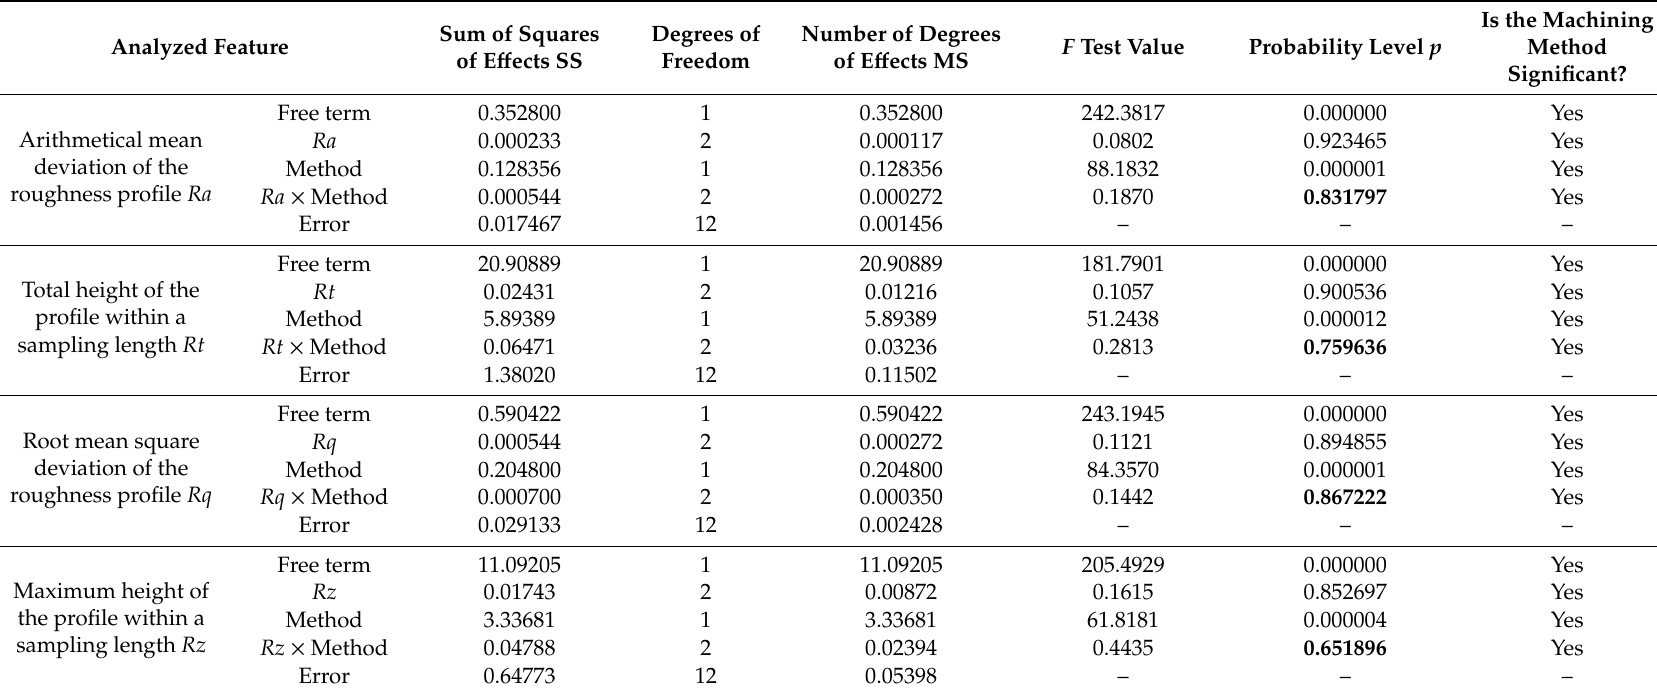
Table 5. Results of the analysis of variance by the ANOVA method of the obtained surface texture measurements (in the table, the probability values for the features under consideration are